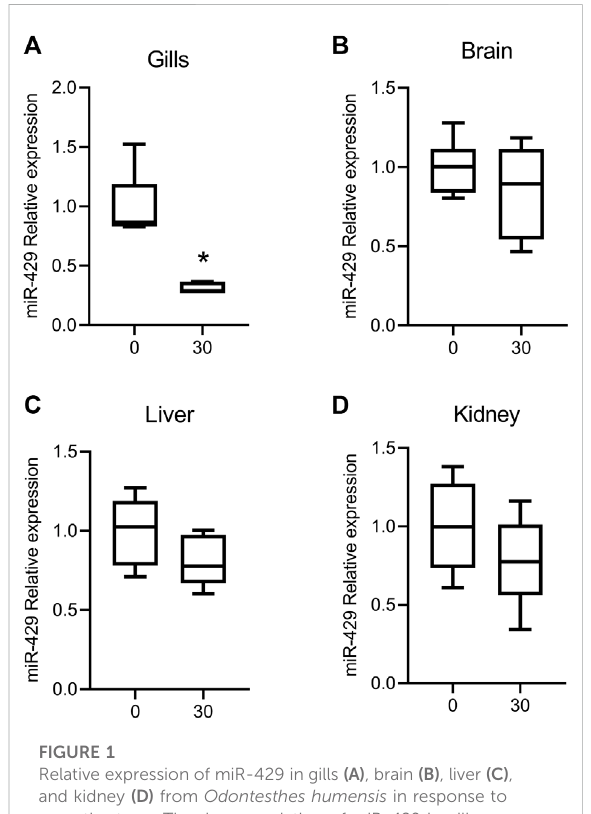
FIGURE 1 Relative expression of miR-429 in gills (A) , brain (B) , liver (C) , and kidney (D) from Odontesthes humensis in response to osmotic stress. The downregulation of miR-429 in gills was detected 24 h after 30 g.L − 1 of salt using two-step RT-qPCR. The group exposed to 0 g.L − 1 was taken as the control group. The box extends from the 25th to 75th percentiles, while the whiskers go down to the smallest value and up to the largest. The data was expressed as the relative change compared with the control group. Asterisk ( p ) indicates signi fi cant difference compared with the control group ( p p < 0.05).